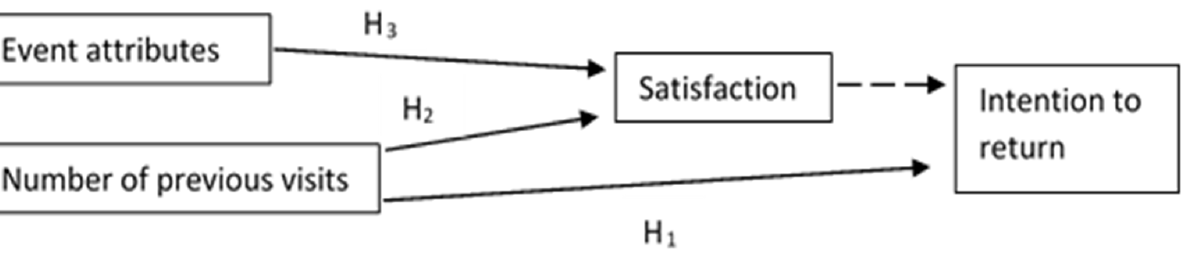
Figure 1. Proposed research model.